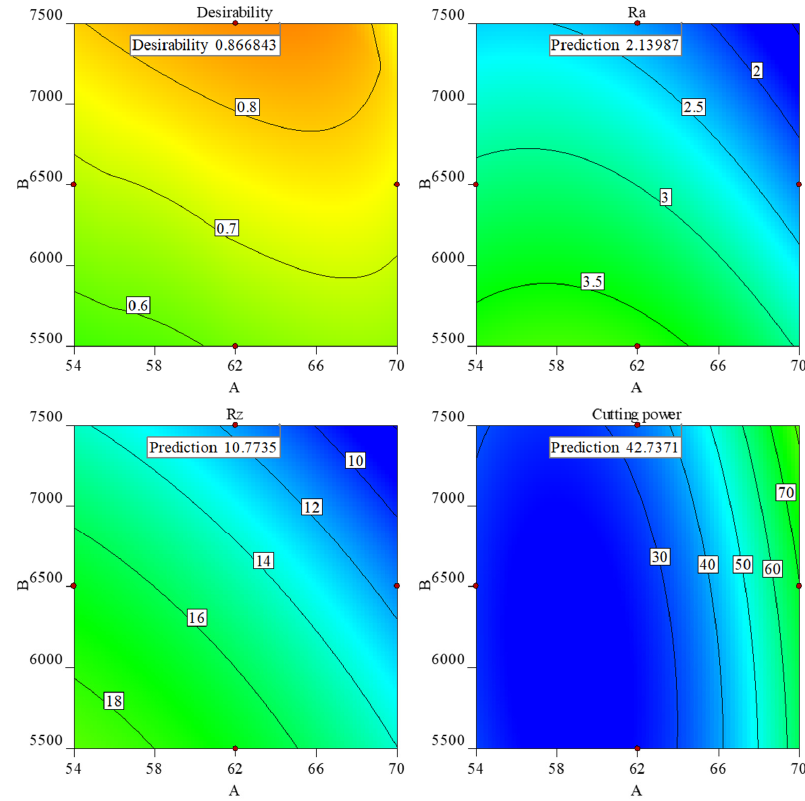
Figure 7. The contour plot of